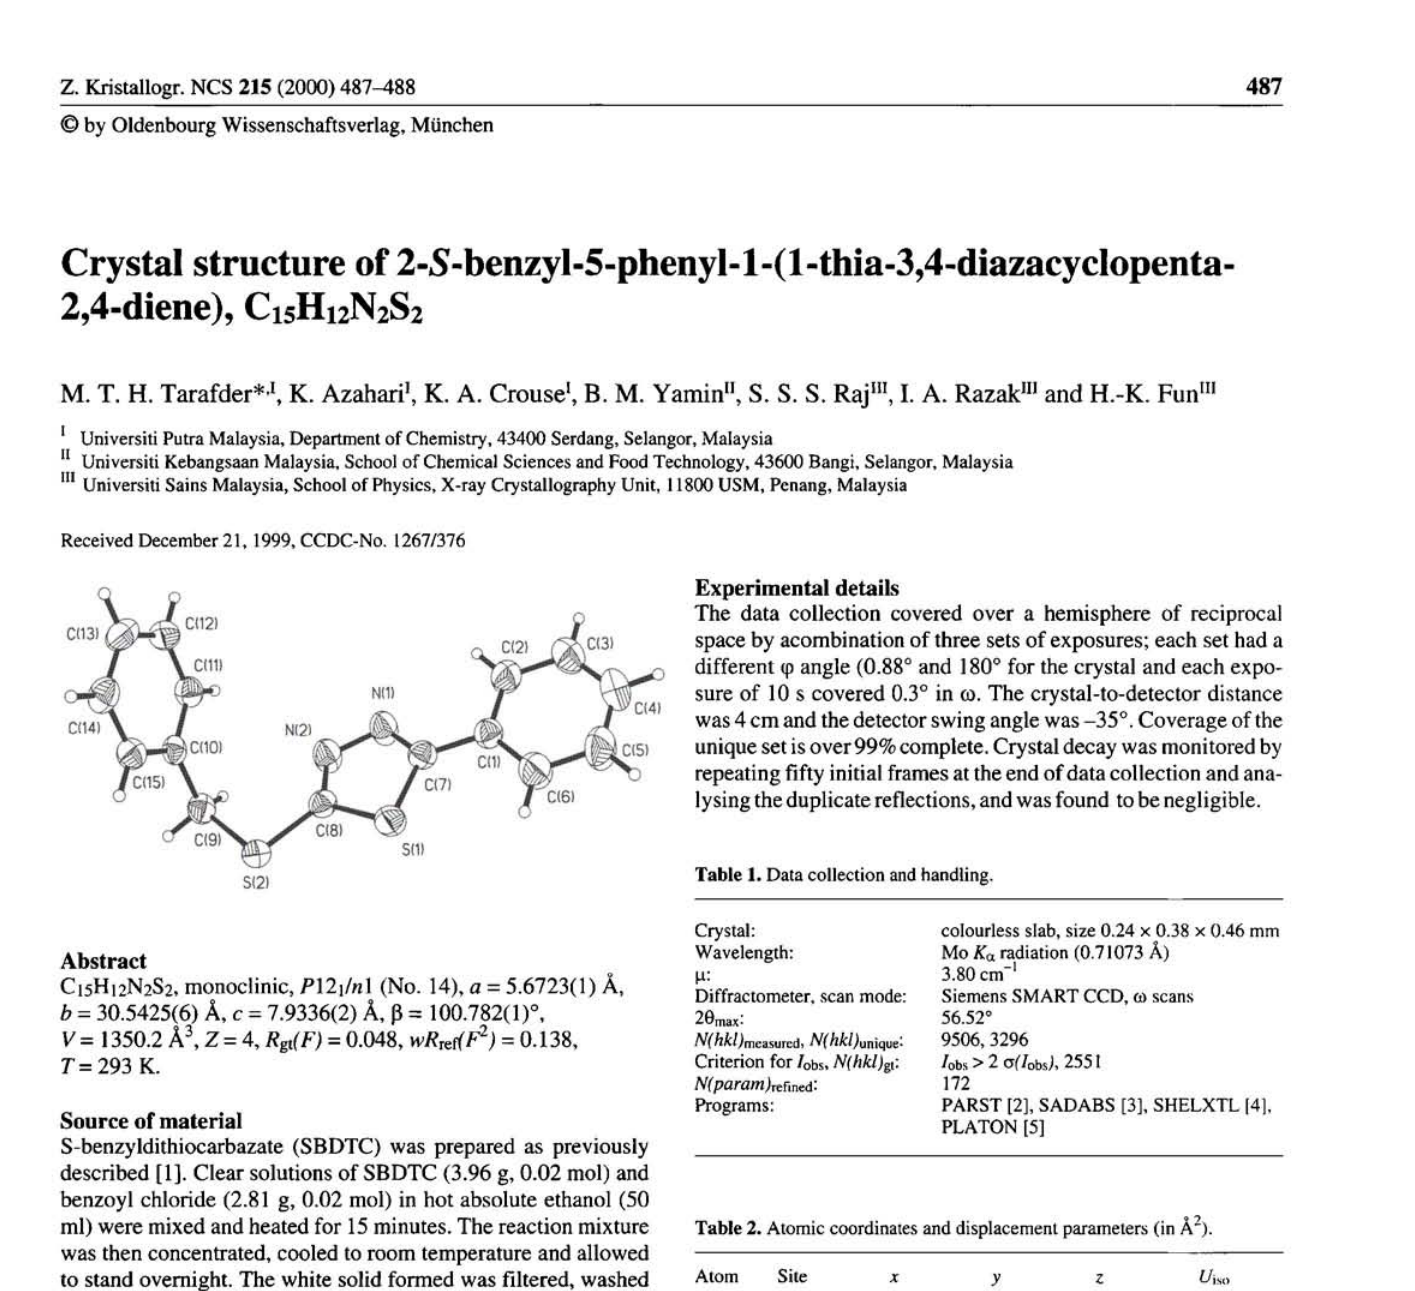
Table 2. Atomic coordinates and displacement parameters (in Â 2